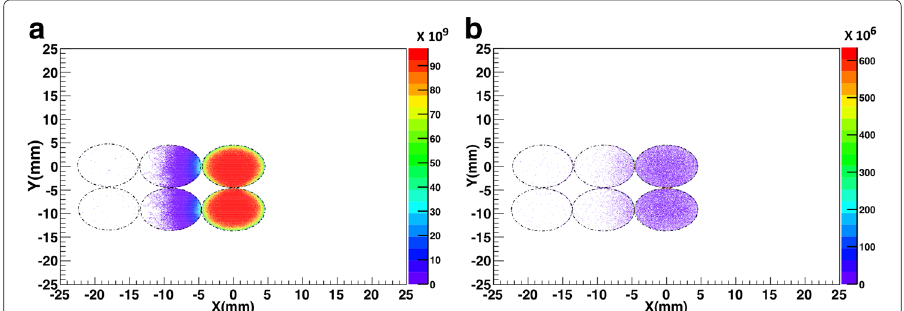
Fig. 8 a Two-dimensional energy histogram for six adjacent wells by integrating the corresponding 3D energy distribution along the Z direction. The scale bar is in MeV. b Two-dimensional beta particle fluence histogram for six adjacent wells by integrating the corresponding 3D fluence distribution along the Z direction. Black dotted circles indicate the edges of the